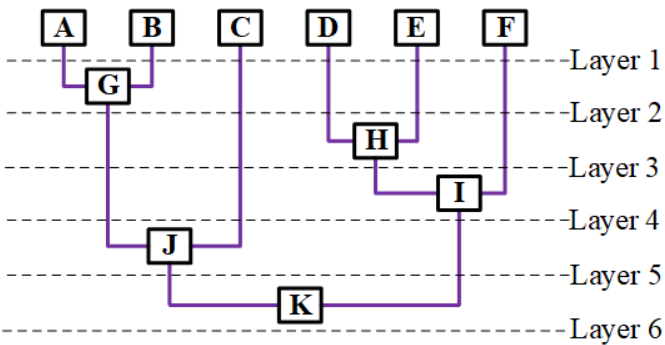
Figure 2. The dendrogram of the merged hierarchical clustering.